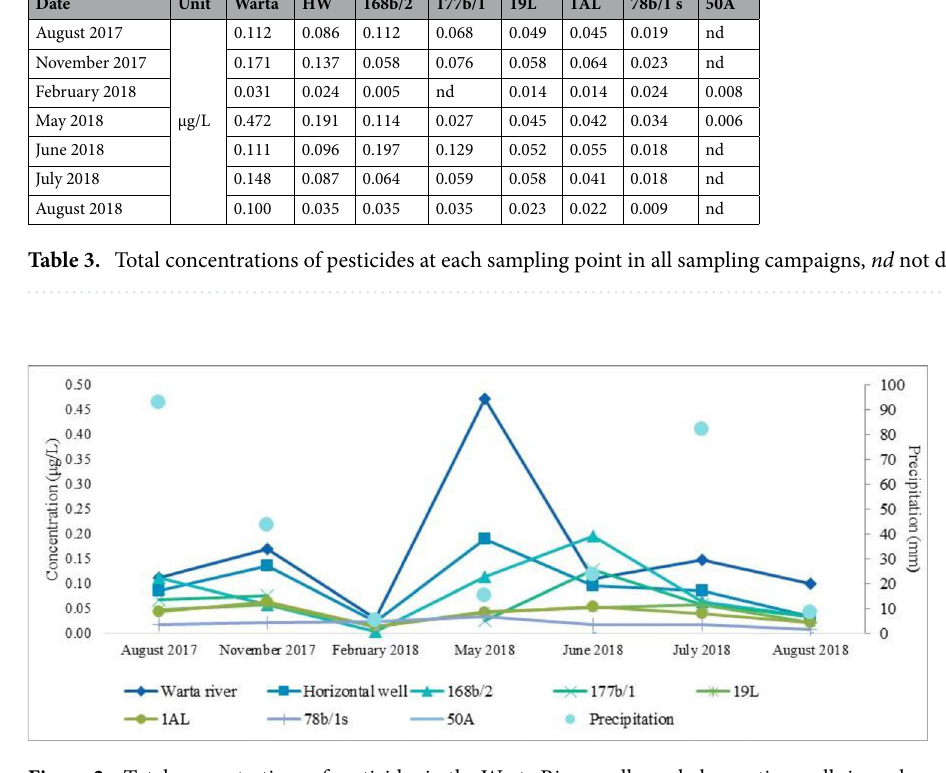
Figure 2. Total concentrations of pesticides in the Warta River, wells, and observation wells in each sampling campaign, and total monthly